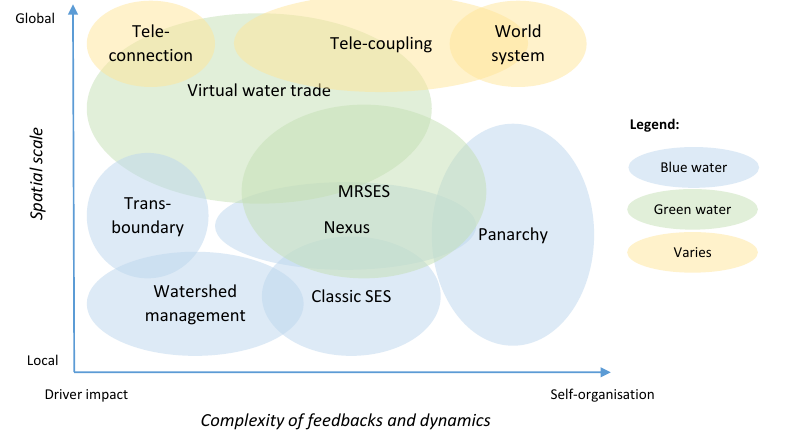
Figure 6. Concept of MRSES in relation to other concepts pertinent to human–water system research along the axes of spatial scale and feedback complexity considered and in terms of water flows considered. Blue water refers to liquid water in rivers, lakes, and aquifers, whereas green water here refers to terrestrial evaporation and moisture